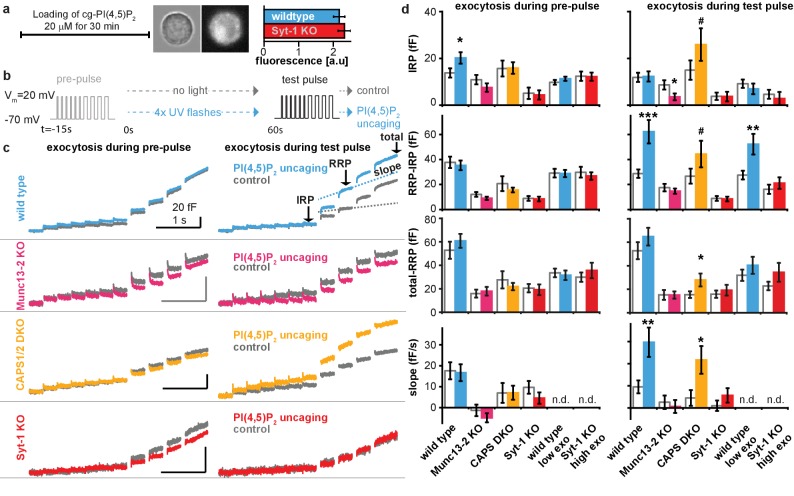
Uncaging cg-PI(4,5)P2 in-between the pre-pulse and the test pulse enhances exocytosis during the test-pulse.Supplementary data figure of electrophysiological experiments depicted in Figures 5 and 6. (a) Loading protocol. Cells were incubated with cg-PI(4,5)P2 for 30 min leading to reliable uptake of cg-PI(4,5)P2 as indicated by the coumarin fluorescence (bright field and fluorescence images of a wildtype cell inserted, histogram shows mean intensity ± SEM, differences between means were tested by a Student’s two tailed t-test: p=0.533). (b) Physiological paradigm to investigate the effect of PI(4,5)P2 uncaging on exocytosis. (c) Average capacitance traces of exocytosis elicited during the pre-uncaging depolarization train (pre-pulse, left) and during the identical test pulse (right). The average exocytosis of wild type (light blue), Munc13-2 KO (magenta), CAPS1/−2 DKO (yellow) and syt-1 KO (red) which were subjected to UV uncaging in-between the pre- and the test pulse are shown together with their respective controls (grey, no uncaging). As expected, exocytosis in response to the pre-pulse was identical between cells in the uncaging group compared to their controls (due to identical treatment at this stage, the distinction in terms of light treatment occurs later). (d) Quantification (mean ±SEM) of data in (c), performed as outlined in Figure 5a for all genotypes. To investigate whether the magnitude of exocytosis influenced the PI(4,5)P2-sensitivity, we analyzed subsets of wild type cells with intrinsically low exocytosis (wild type low exo, with suitable maximal thresholds (0 < IRP < 20 fF, 0<(RRP-IRP)<80 fF, 0<(total-RRP)<65 fF) during pre-pulse) and of syt-1 KO cells with intrinsically higher exocytosis (syt-1 KO high exo, with suitable minimal thresholds (3 fF <IRP, 12 fF<(RRP-IRP), 8 fF<(total-RRP)) during pre-pulse). While release could still be augmented in wild type cells with low release, PI(4,5)P2 uncaging was without effect in syt-1 KO cells with high release. These data argue that the absence of potentiation by PI(4,5)P2 uncaging in syt-1 KO cells is not caused by the lower total exocytosis in these cells, which is in line with the augmenting effect observed in CAPS1/−2 DKO cells, which also have reduced exocytosis. Statistically significant differences between the means were tested using Student’s two-tailed t-test: pre-pulse wild type: (IRP) p=0.0439, (RRP-IRP) p=0.686, (total-RRP) p=0.857, (slope) p=0.868; test-pulse wild type (IRP) p=0.896, (RRP-IRP) p=0.000999, (total-RRP) p=0.256, (slope) p=0.00601; pre-pulse Munc13-2KO: (IRP) p=0.210, (RRP-IRP) p=0.183, (total-RRP) p=0.691, (slope) p=0.311; test-pulse Munc13-2KO (IRP) p=0.0391, (RRP-IRP) p=0.431, (total-RRP) p=0.999, (slope) p=0.650; pre-pulse CAPS DKO: (IRP) p=0.466, (RRP-IRP) p=0.840, (total-RRP) p=0.487, (slope) p=0.989; test-pulse CAPS DKO (IRP) p=0.0762, (RRP-IRP) p=0.0778, (total-RRP) p=0.0449, (slope) p=0.0200; pre-pulse Syt-1KO: (IRP) p=0.813, (RRP-IRP) p=0.149, (total-RRP) p=0.823, (slope) p=0.212; test-pulse Syt-1 KO (IRP) p=0.645, (RRP-IRP) p=0.537, (total-RRP) p=0.607, (slope) p=0.258; pre-pulse wild type low exo: (IRP) p=0.286, (RRP-IRP) p=0.930, (total-RRP) p=0.708; test-pulse wild type low exo (IRP) p=0.448, (RRP-IRP) p=0.00725, (total-RRP) p=0.356; pre-pulse Syt-1 KO high exo: (IRP) p=0.954, (RRP-IRP) p=0.593, (total-RRP) p=0.447; test-pulse Syt-1KO high exo (IRP) p=0.590, (RRP-IRP) p=0.417, (total-RRP) p=0.147. #p<0.08; *p<0.05, ***p<0.001. Scale bars 20 fF/1 s. n.d.: not determined. Number of cells (n) in electrophysiological recordings: n = 50 (wild type control), n = 49 (wild type PI(4,5)P2 uncaging), n = 21 (CAPS1/−2 DKO control), n = 20 (CAPS1/−2 DKO PI(4,5)P2 uncaging), n = 32 (Munc13-2 KO control), n = 37 (Munc13-2 KO PI(4,5)P2 uncaging), n = 33 (syt-1 KO control), n = 36 (syt-1 KO PI(4,5)P2 uncaging).